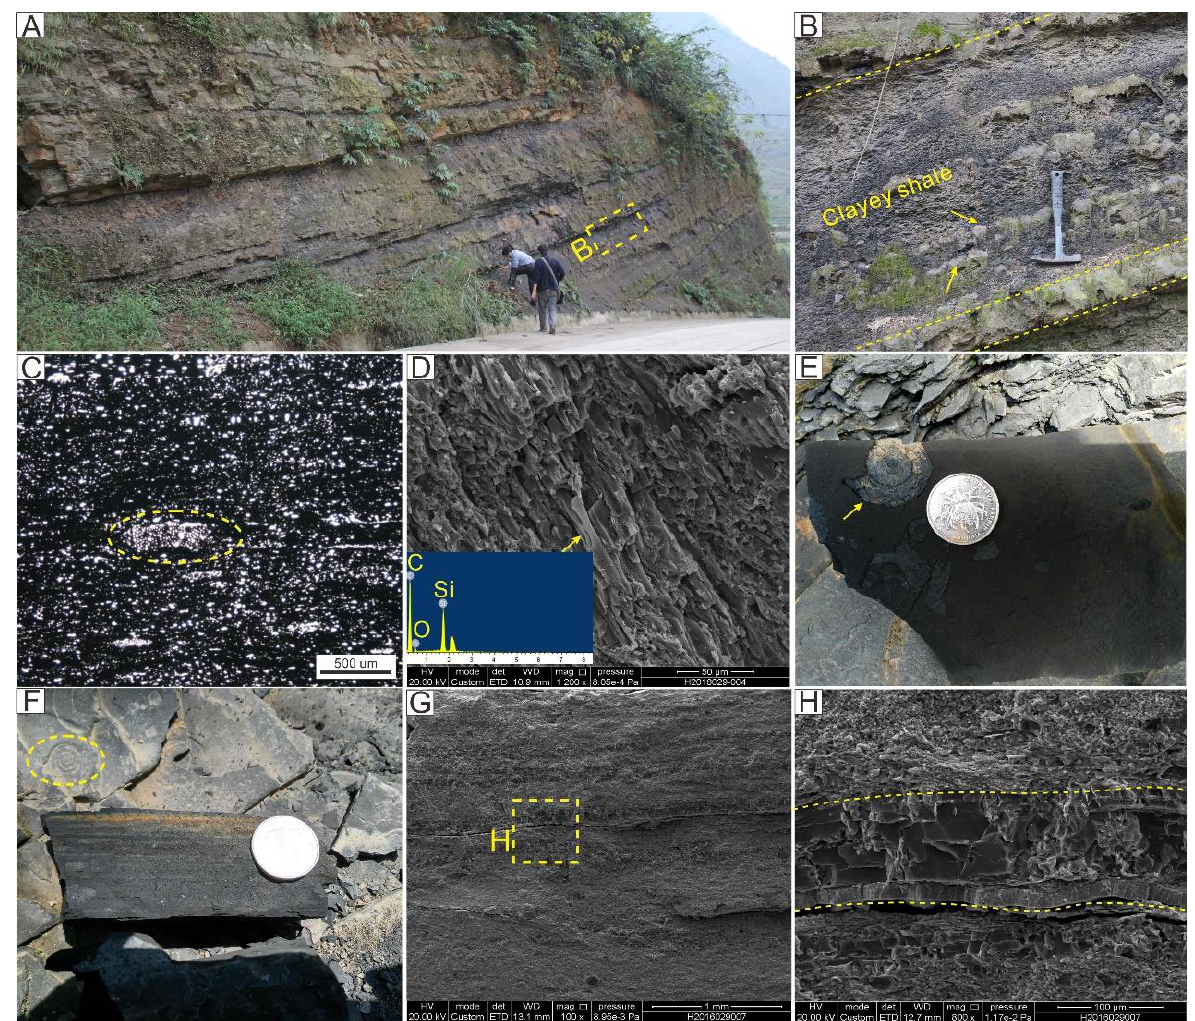
Figure 5. Characteristics of the Longtan clayey shale from field outcrops, photomicrographs and SEM images. ( A ) Field macroscopic characteristics of clayey shale, Xinwen; ( B ) Clayey shale interspersed with calcareous nodules, Xinwen; ( C ) Plant fossil fragment in the clayey shale, PPL, Xinwen; ( D ) Plant fossil fragment and energy spectra, SEM, Xinqiao; ( E ) Ammonites up to 2 cm in length in the black clayey shale, Yuanbao; ( F ) Black clayey shale with horizontal laminations, Yuanbao; ( G , H ) organic matter and clay minerals presented in parallel, Yuanbao.